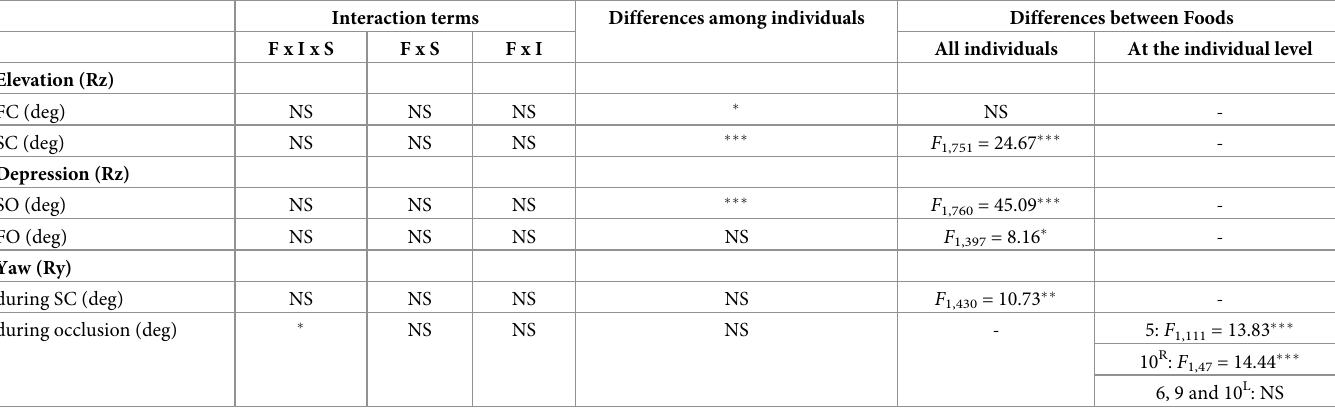
Table 5. Summary of the effects of food toughness (i.e., apple versus carrot) on the variability of jaw movements. Interaction terms